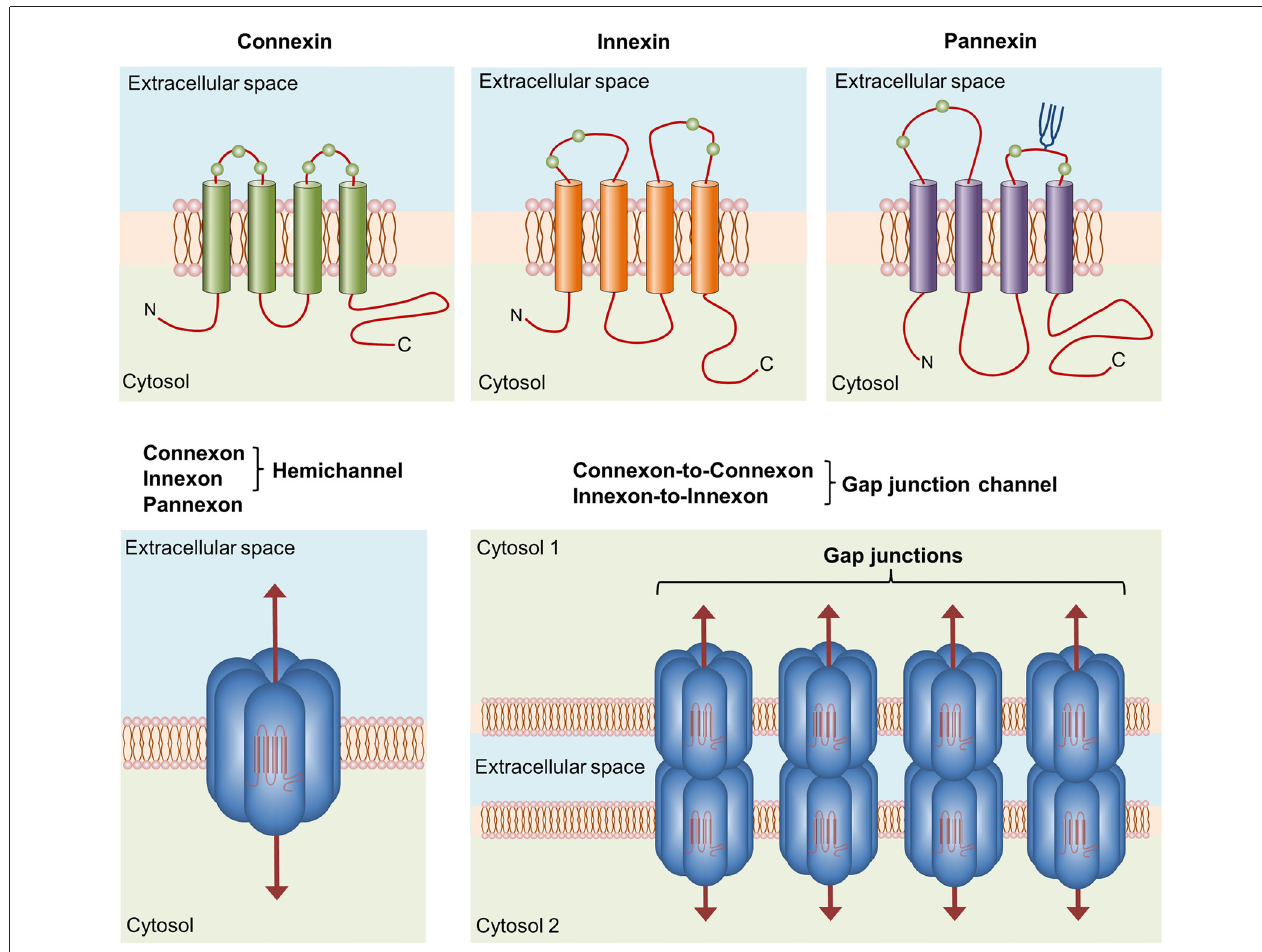
FIGURE 1 | Basic structure of channels formed by connexins, innexins and pannexins. Connexins, innexins and pannexins share similar membrane topologies consisting of four α -helical transmembrane domains connected by two extracellular loops and one cytoplasmic loop; both the amino- and carboxy-termini are intracellular. The relative positions of the extracellular loop cysteines (green balls) and glycosylated asparagines (blue branches) are also shown. Connexons or innexons (also known as hemichannels (HCs)) are formed from connexins or innexins consisting of six subunits each. Pannexons are single membrane channels composed of six pannexin subunits. Recently, a Panx2 band pattern more consistent with an octamer than a hexamer was observed in cross-linking studies and native gels examining purified homomeric full-length and C-terminal truncation mutants (Ambrosi et al., 2010). Under resting conditions, HCs and pannexons remain preferentially closed, but they are activated by diverse physiological and pathological conditions and represent a diffuse transmembrane route between the intra- and extracellular milieu. HCs dock with one another to form functional cell-to-cell channels termed gap junction channels (GJCs). GJCs aggregate in well-known anatomical structures called gap junctions to facilitate the intercellular exchange of metabolites, second messengers and